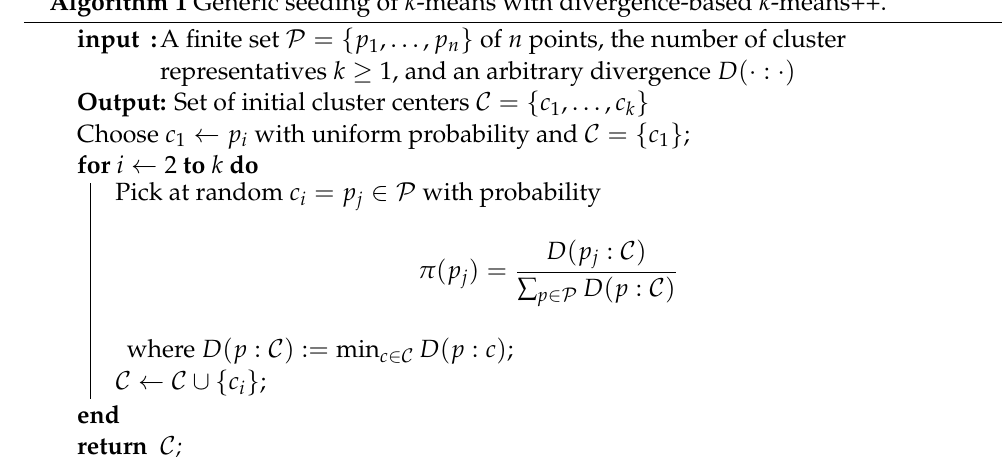
Algorithm 1 Generic seeding of k -means with divergence-based k